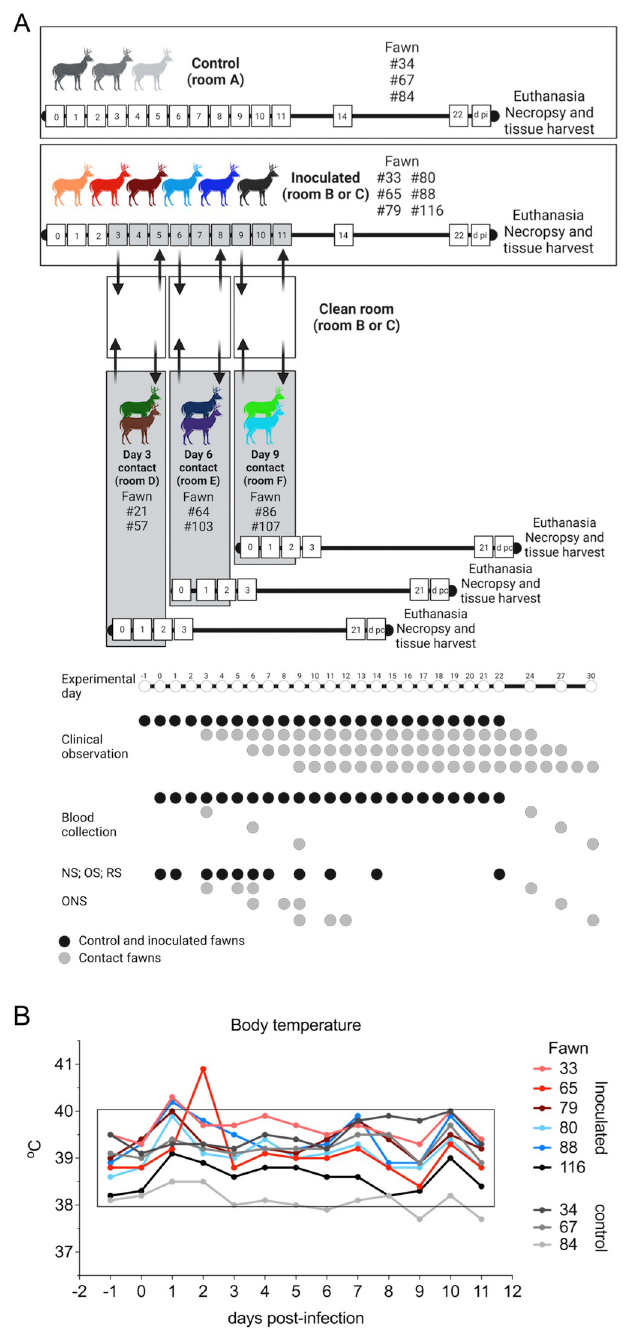
Fig 1. Infection and transmission study of SARS-CoV-2 in white-tailed deer. A ) Schematic representation of the experimental design of infection/transmission study in WTD fawns. Three fawns were maintained as control (non- inoculated) in room A, and six fawns were inoculated intranasally with SARS-CoV-2 and housed in room B or C for 22 days post-inoculation (d pi). On day 3 pi two fawns (day 3 contact) were moved into a clean room (room C) where the inoculated fawns were also introduced. After 48 hours, day 3 contact fawns were transferred to a separate clean room (room D), where they were maintained until euthanized on 21 days post-contact (d pc). This process was performed with two additional fawns on day 6 pi (day 6 contact) and two fawns on day 9 pi (day 9 contact), which were housed in the separate rooms E and F, respectively. Respiratory nasal secretion, feces and serum were collected on the days indicated in the figure. B ) Inoculated and control fawns were microchipped subcutaneously with temperature chips prior to the experiment, and monitored daily for body temperature starting on day 1 before inoculation until day 11